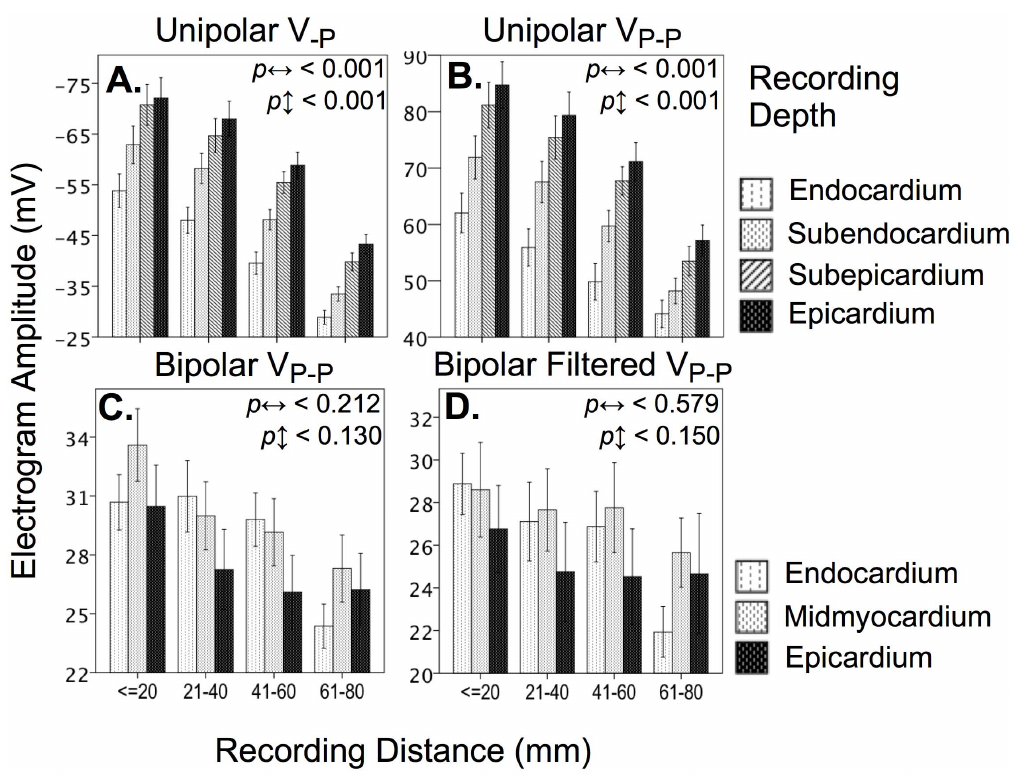
Figure 3. Plots showing effect of recording distance from stimulation source and recording depth on contact electrograms measured during multisite pacing of left ventricular myocardium. There was a significant inverse relationship between recording distance from stimulus location and unipolar electrogram amplitude that was not significant for bipolar electrograms. Values represent between-sheep mean 6 S.E, where; p « is the probability of effects relative to propagation distance; and p ? is probability of transmural effects. A. Unipolar V -P ; B. Unipolar V P-P ; C. Bipolar V P-P ; and D. Filtered bipolar V P-P . See figure 1 for electrode locations. doi:10.1371/journal.pone.0110399.g003 PLOS ONE |